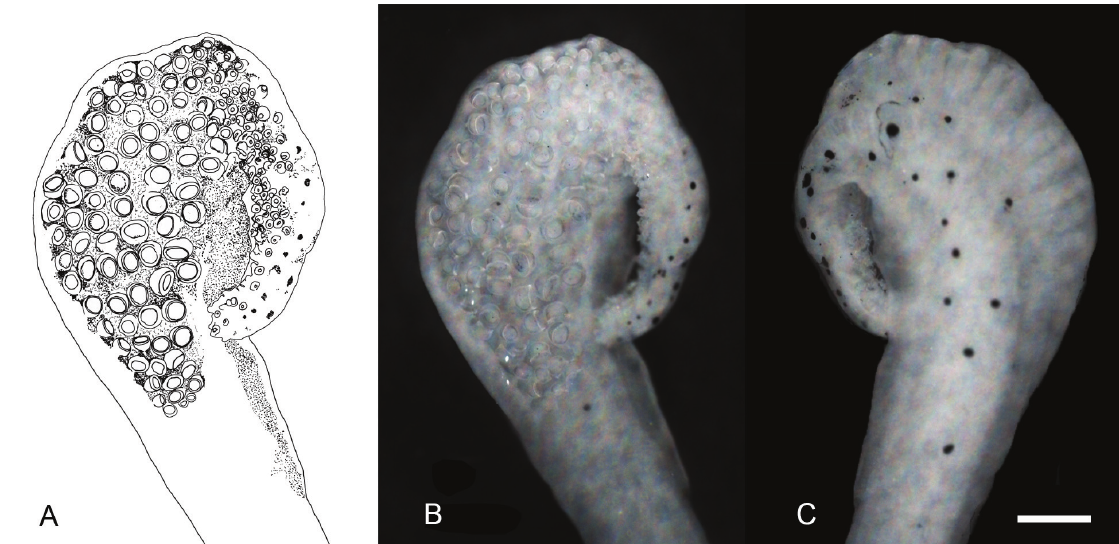
Fig. 3. Right tentacle club of Sepiola boletzkyi sp. nov., holotype, ♂, ESFM-CEP/1994-1. A . Oral view (drawing). B . Oral view. C . Dorsal view. Scale bar = 1 mm.